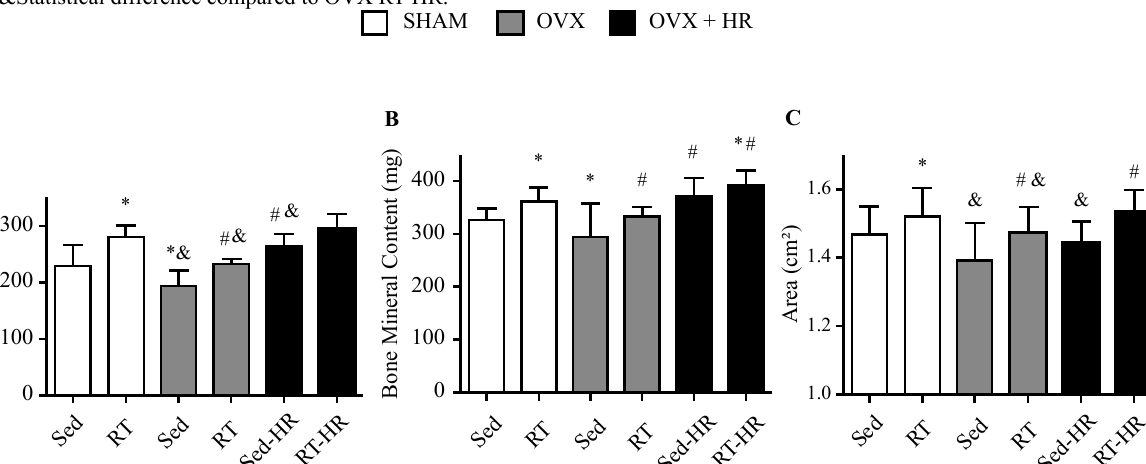
FIGURE 2: Calcium (Ca ++) and phosphorus (P) analysis of the left tibia: A) calcium (mg Ca ++ /mg Bone), B) phosphorus (g P/g Bone). Values are presented as mean ± standard deviation of mean (SDM), P < 0.05. *Statistical difference compared to SHAM Sed; #Statistical difference to group OVX Sed.